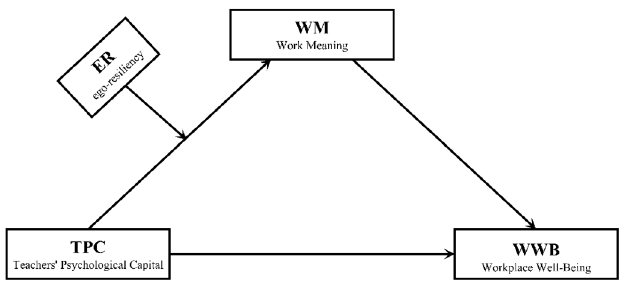
Figure 1. Hypothetical Model of four main variables . Note: TPC, teachers’ psychological capital; ER, ego-resiliency; WM, work-meaning cognition; WWB, workplace well-being.